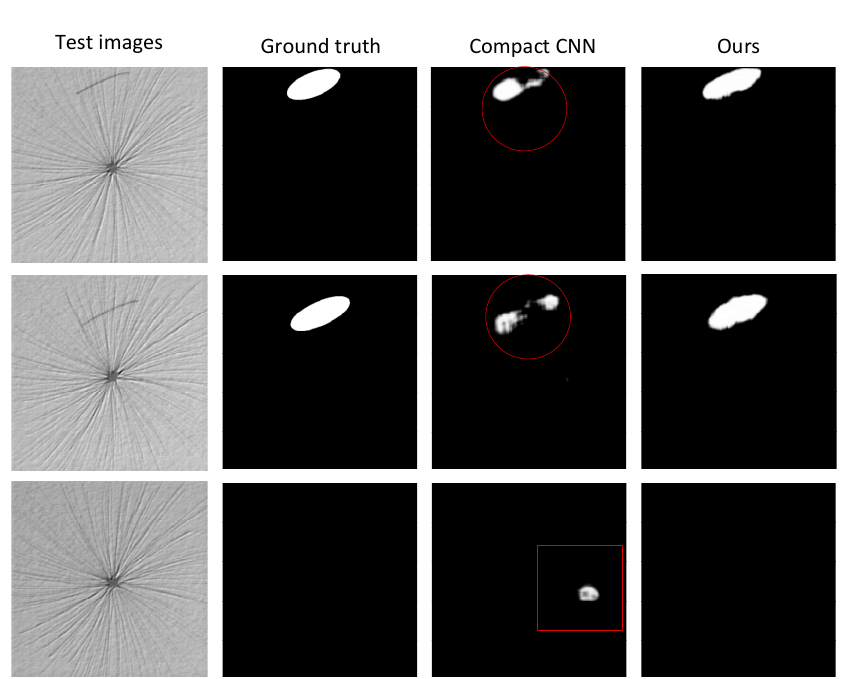
Figure 6. Examples compared with Compact CNN. The red circles and squares denote information loss owing to the lack of detailed features and the areas erroneously detected due to background interference,